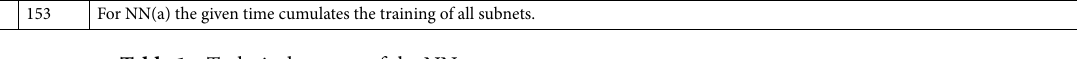
Table 1. Technical aspects of the